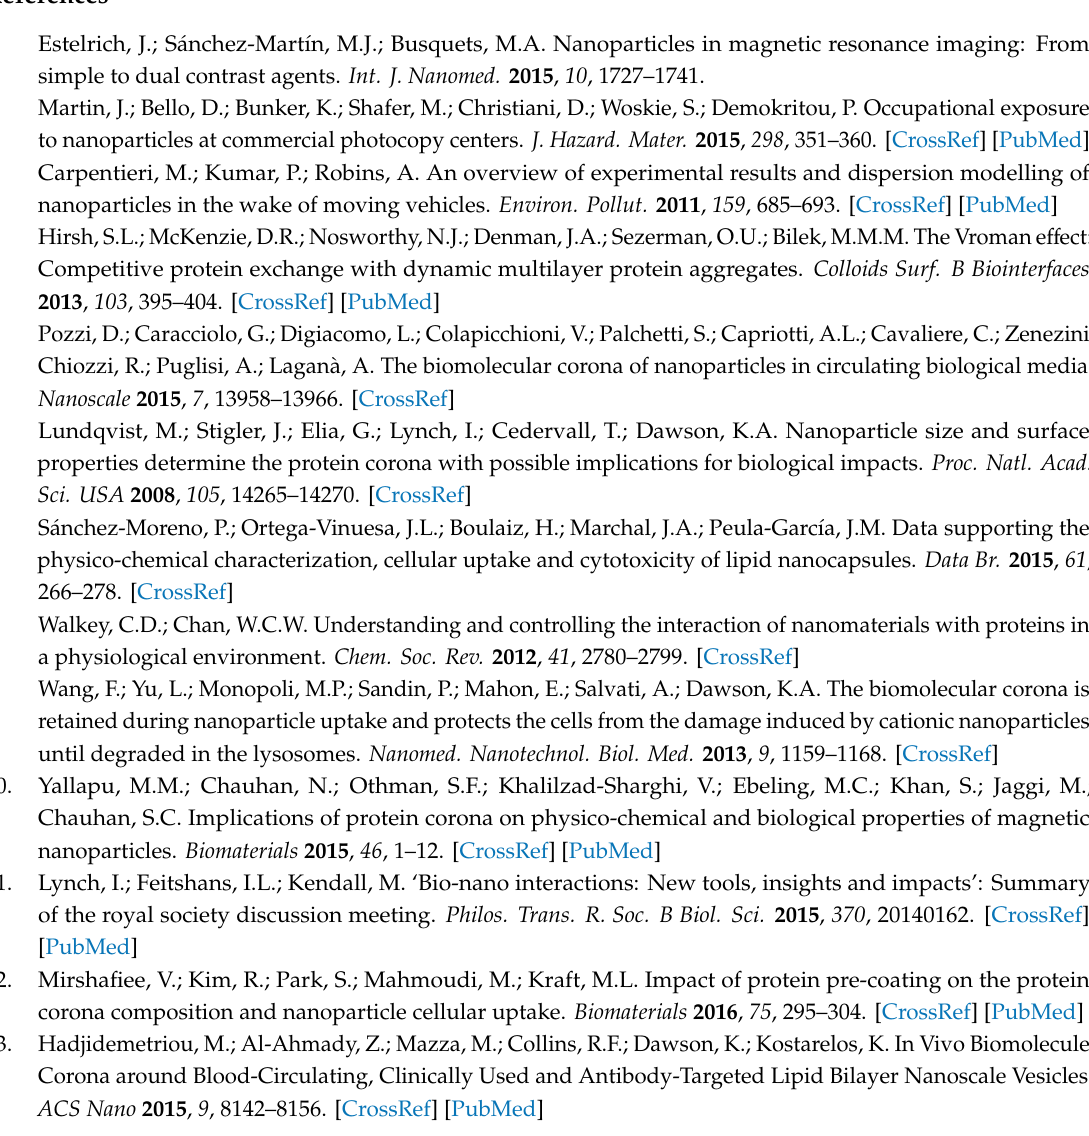
Figure S1: Surface Chemistries of coatings used to stabilise the TiO 2 NMs, Figure S2: NanoMILE Standard Operating Protocol for NM dispersion in cell culture medium, Figure S3: TEM Images of TiO 2 NM, Figure S4: DLS and ICP-MS Characterisation of TiO 2 NMs, Figure S5: FITC-Serum binding to TiO 2 NM versus Controls, Figure S6: Segmentation and Measurement of Biostation Images, Figure S7: Segmentation and Measurement of Confocal Images, Figure S8: Cumulative Confocal Data, Figure S9: STORM imaging Controls, Figure S10: STORM imaging increases resolution and allows for improved detection, Figure S11: Analysis of Cluster Area and